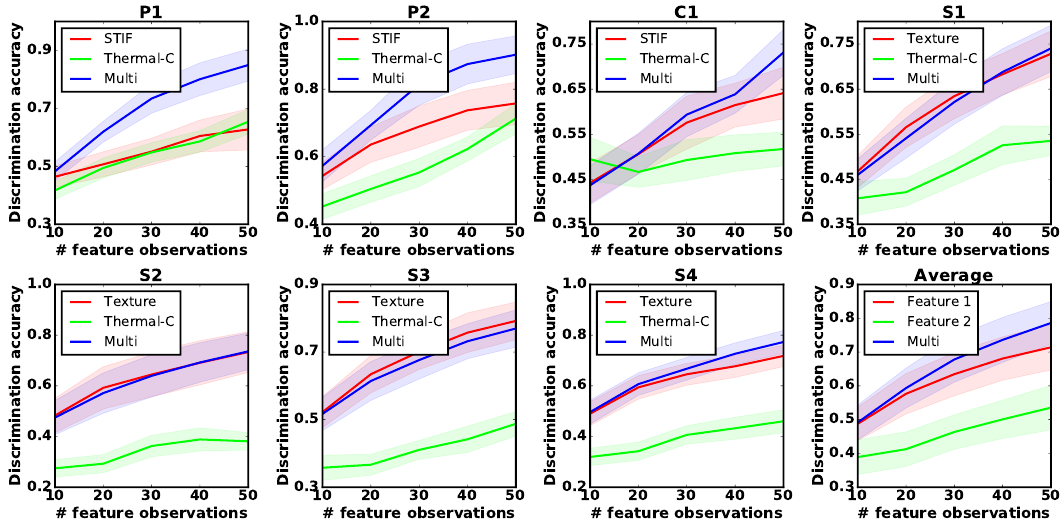
Figure 6. Multiple feature observations combination results for exploratory actions P 1, P 2, C 1, S 1, S 2, S 3, S 4 and the averaged result. STIF: building the GPC observation model based on object stiffness; Thermal-C: thermal conductivity; Texture: object surface textural properties; Multi: combined feature observations. The horizontal axis represents the number of feature observations. The vertical axis represents the discrimination accuracy of the test